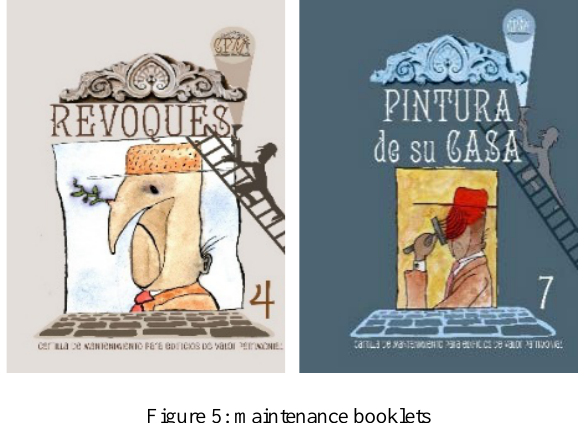
Figure 5: maintenance booklets